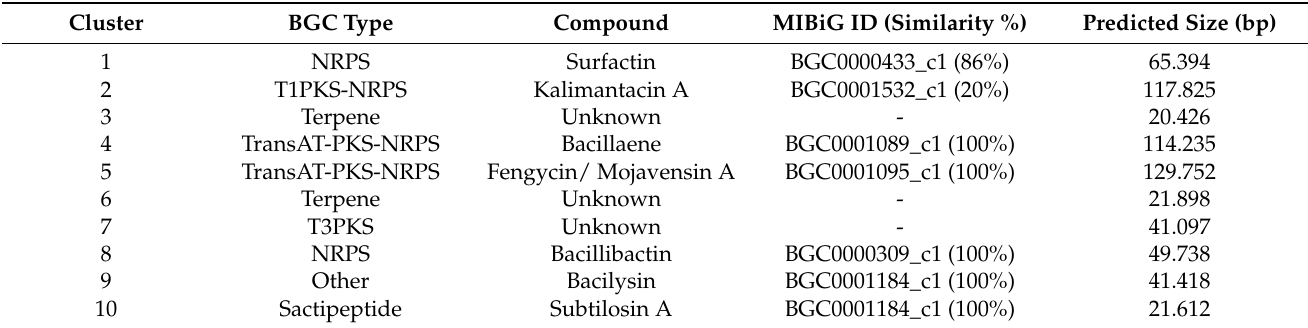
Table 1. Biosynthetic gene clusters (BGCs) involved in biosynthesis of secondary metabolites of bacterial strain B. halotolerans Cal.l.30, detected by antiSMASH